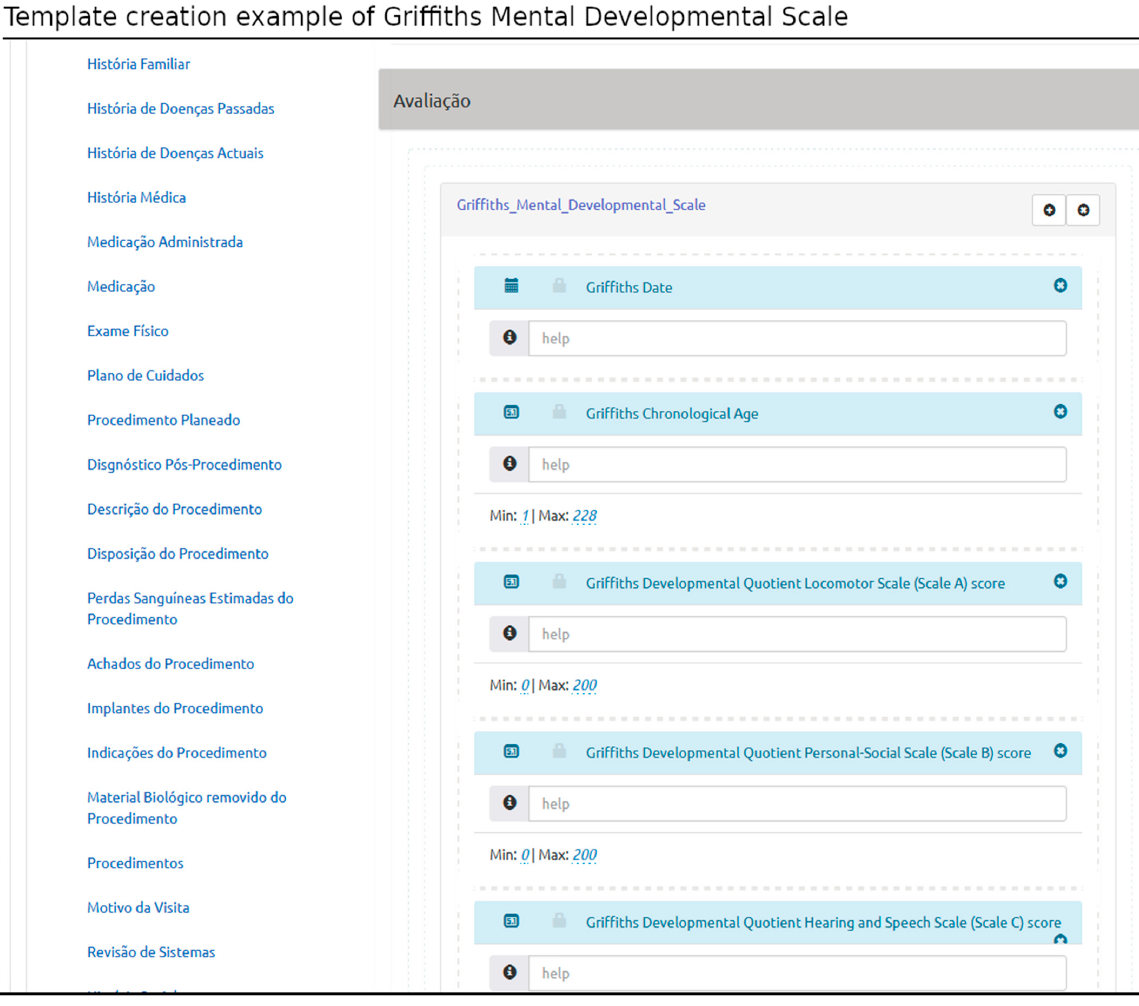
Figure 2. Example of template creation interface. In this case, the template creation of the Griffiths Mental Developmental Scale is shown. The template is included in the assessment section, named “Avaliação” in the Portuguese language. Other possible sections to capture healthcare information are listed at left (top to bottom English translation: Family History; History of Past Diseases; History of Current Diseases; Clinical History; Medication Administered; Medication; Physical Exam; Care Plan; Planned Procedure; Post-Procedure Diagnosis; Procedure Description; Disposition of the Procedure; Estimated Blood Loss From the Procedure; Procedure Findings; Procedure Implants; Procedure Indications; Biological Material Removed From the Procedure; Procedures; Reason of the Visit; and Systems